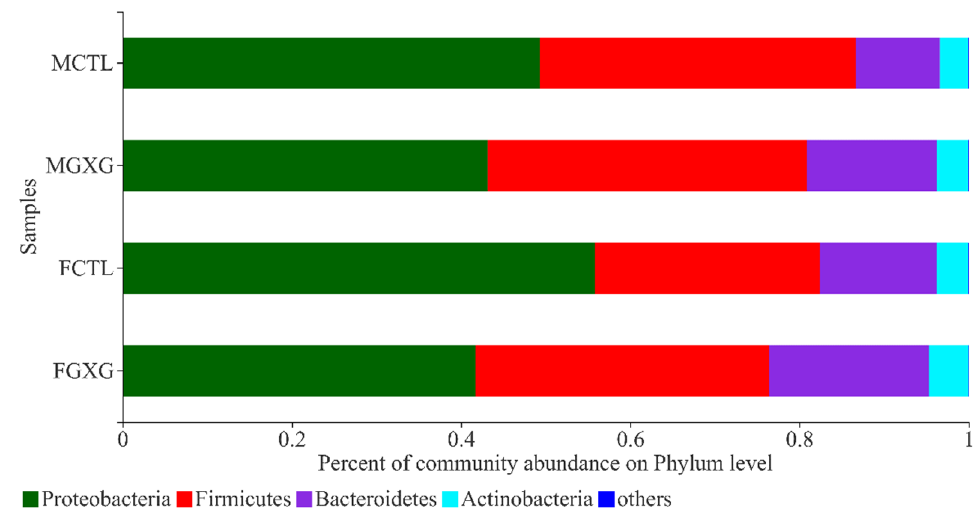
Figure 3. Effect of Dendrobium officinale polysaccharides on the relative abundance of microbiota at the phylum level.